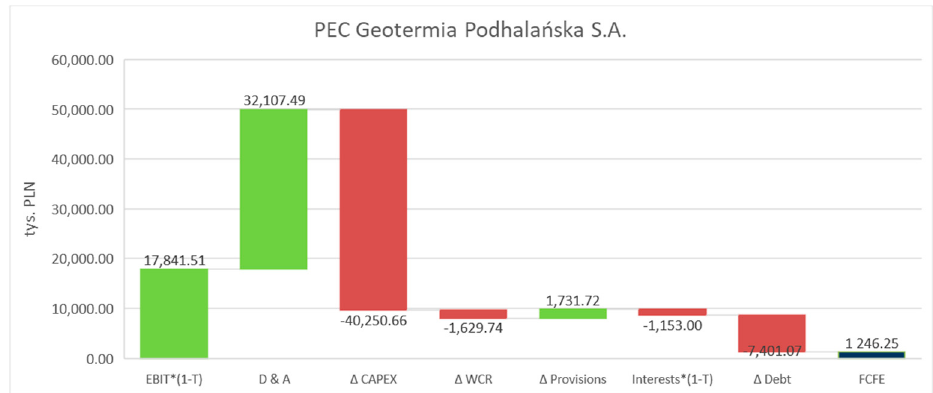
Figure 10. FCFF cash flows generated by PEC Geotermia Podhala ń ska S.A. in 2016–2019. Source: Own study on the basis of: [51].